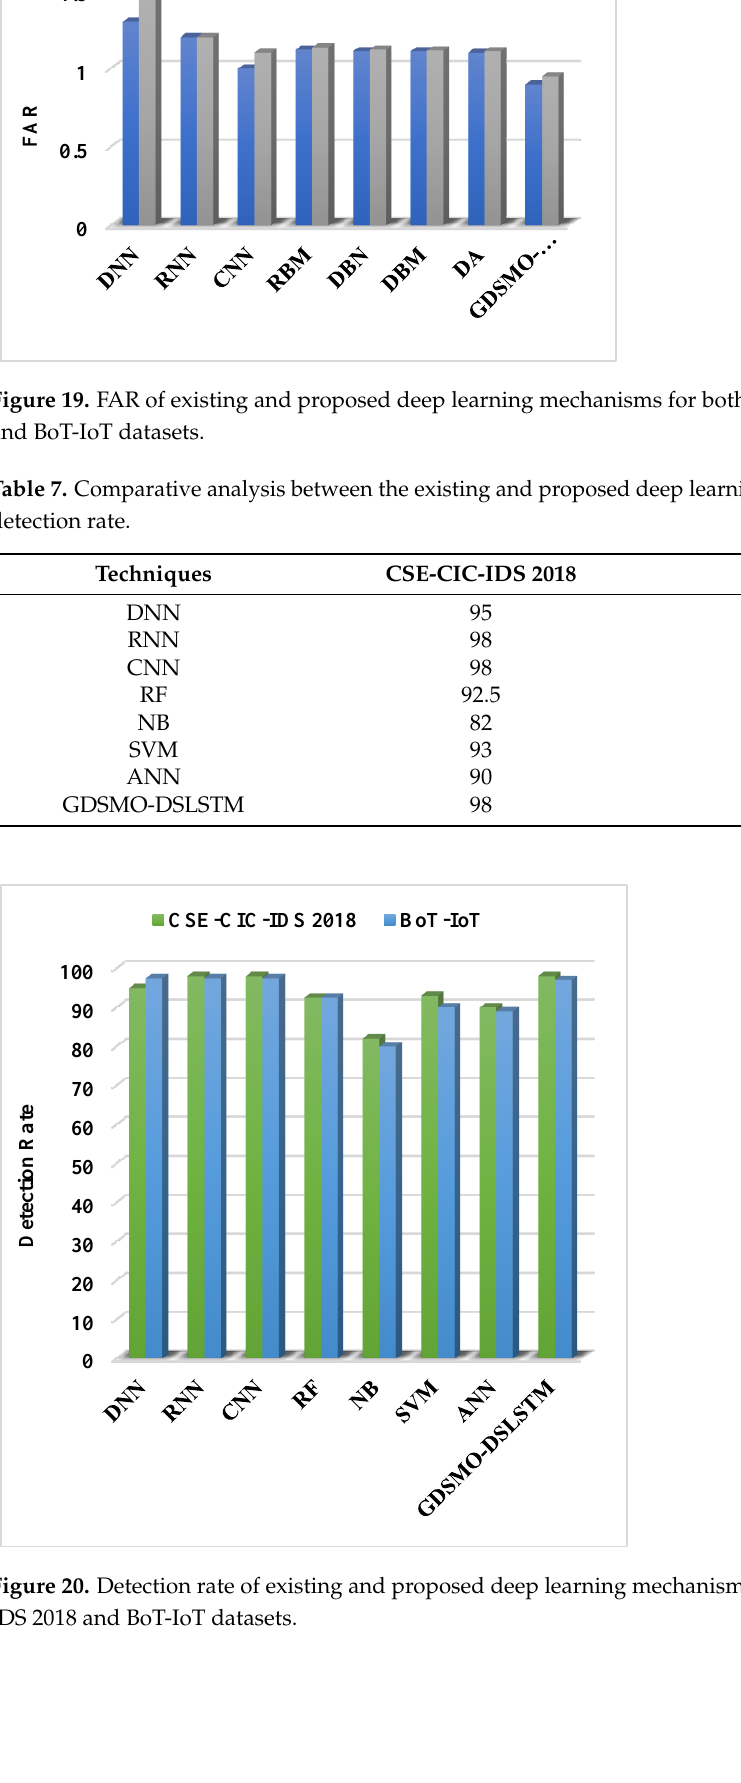
22 of 26 Figure 18. Comparative analysis between existing and proposed techniques using the SCADA network dataset. Table 6. Comparative analysis between the existing and proposed deep learning techniques based on FAR.